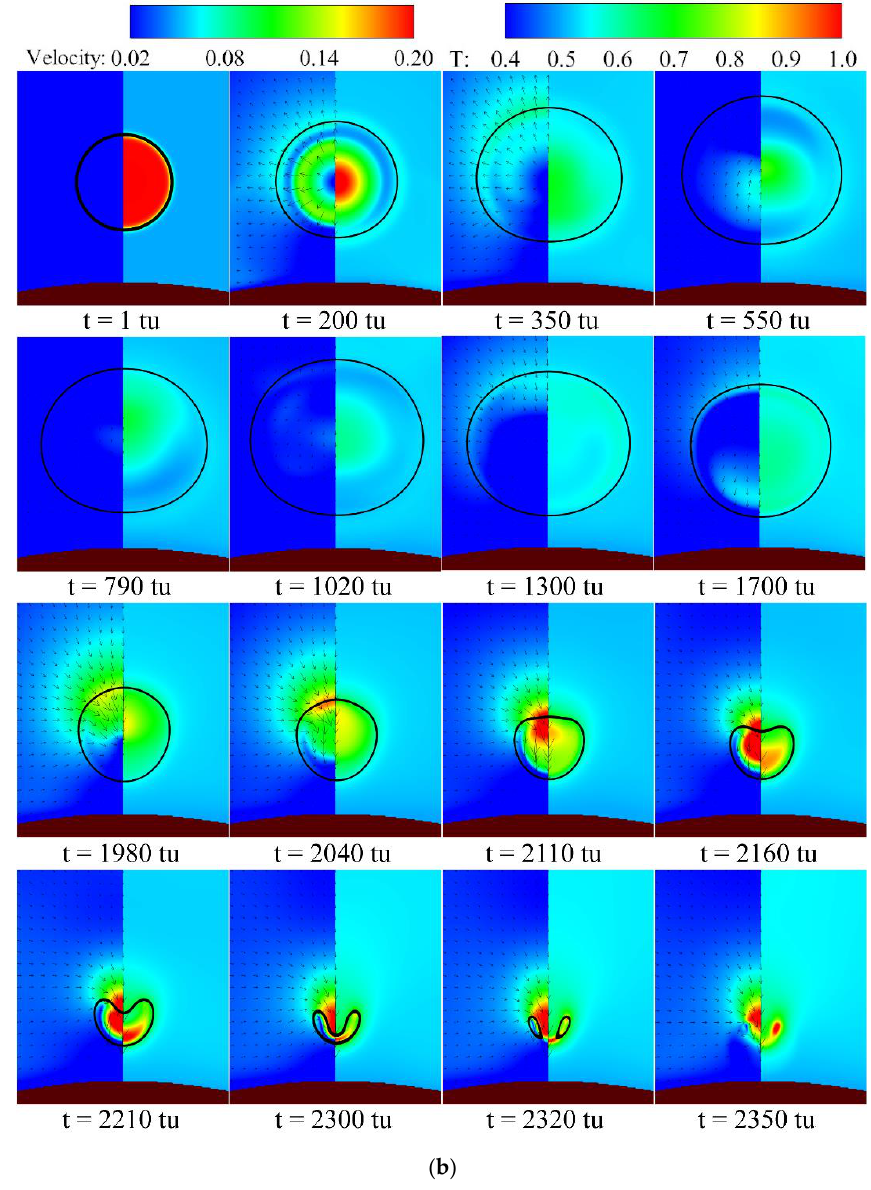
Figure 11. The velocity and the temperature fields for different curvatures by DDF-LBM model ( a ) ξ = 0.22; ( b ) ξ =